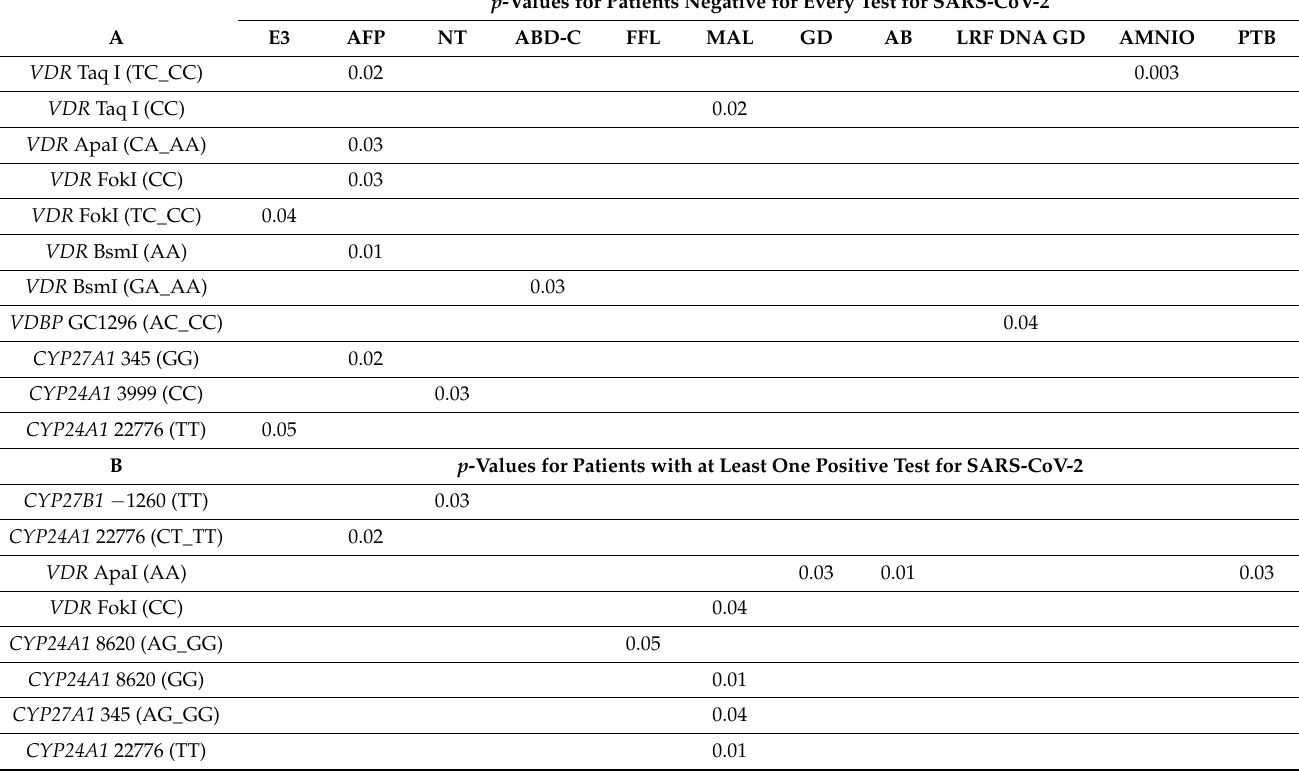
Different vitamin D pathway related SNPs were able to affect some clinical features (Table 2): in particular, VDR ApaI AA genotype was associated with preterm birth (PTB) in positive patients ( p = 0.03). Moreover, third-trimester vitamin D levels were lower in PTB compared to full-term pregnancy ( p < 0.001, Table 3, Figure 3a): in particular, this trend was evidenced for both SARS-CoV-2 positive and negative patients (at least one test), but a strong p -value of 0.01 was suggested for positive subjects (Figure 3b), whereas a borderline statistical significance ( p = 0.07) was found for SARS-CoV-2 negative women (Figure 3c). Table 2. Influences of genetic polymorphisms with pregnancy characteristics in patients negative on every test for SARS-CoV-2 (A) and patients with at least one positive on a test for SARS-CoV-2 (B) (E3 = estriol; AFP = alpha-fetoprotein; NT = nuchal translucency; ABD-C = abdominal circumfer- ence; FFL = fetal femur length; MAL = malformations; GD = gestational diabetes; AB = abortion; LRF DNA GD = low risk fetal DNA for genetic disease; AMNIO = amniocentesis; PTB = preterm birth). p -Values for Patients Negative for Every Test for SARS-CoV-2